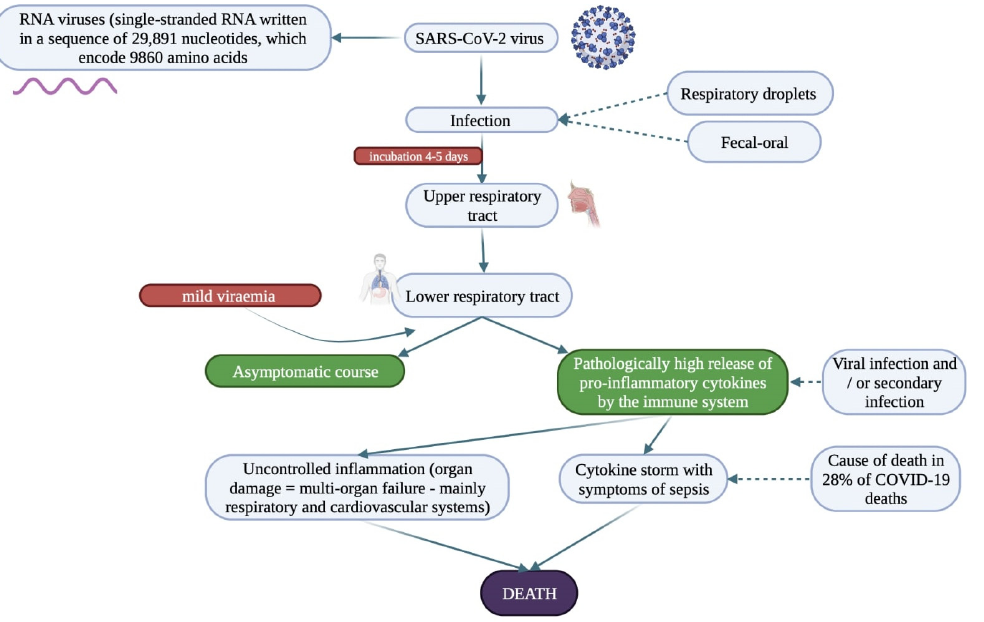
Figure 2. Diagram presenting the course of infection caused by the SARS-CoV-2 virus and possible options for the pathway of the disease process [101,103,107,108].